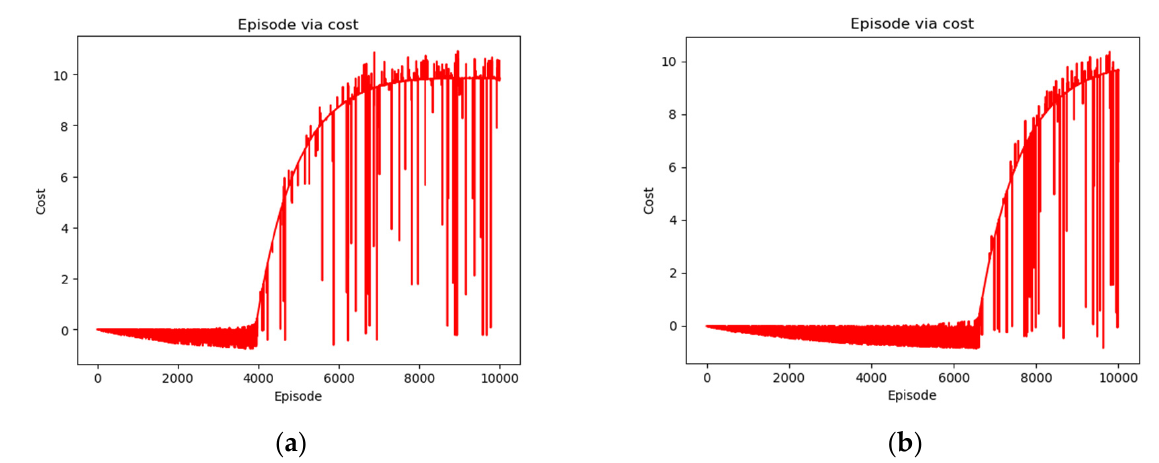
Figure 14. Change graph of cumulative rewards during training. ( a ) Cumulative reward for the no-fire environment; ( b ) Fire environment cumulative reward.